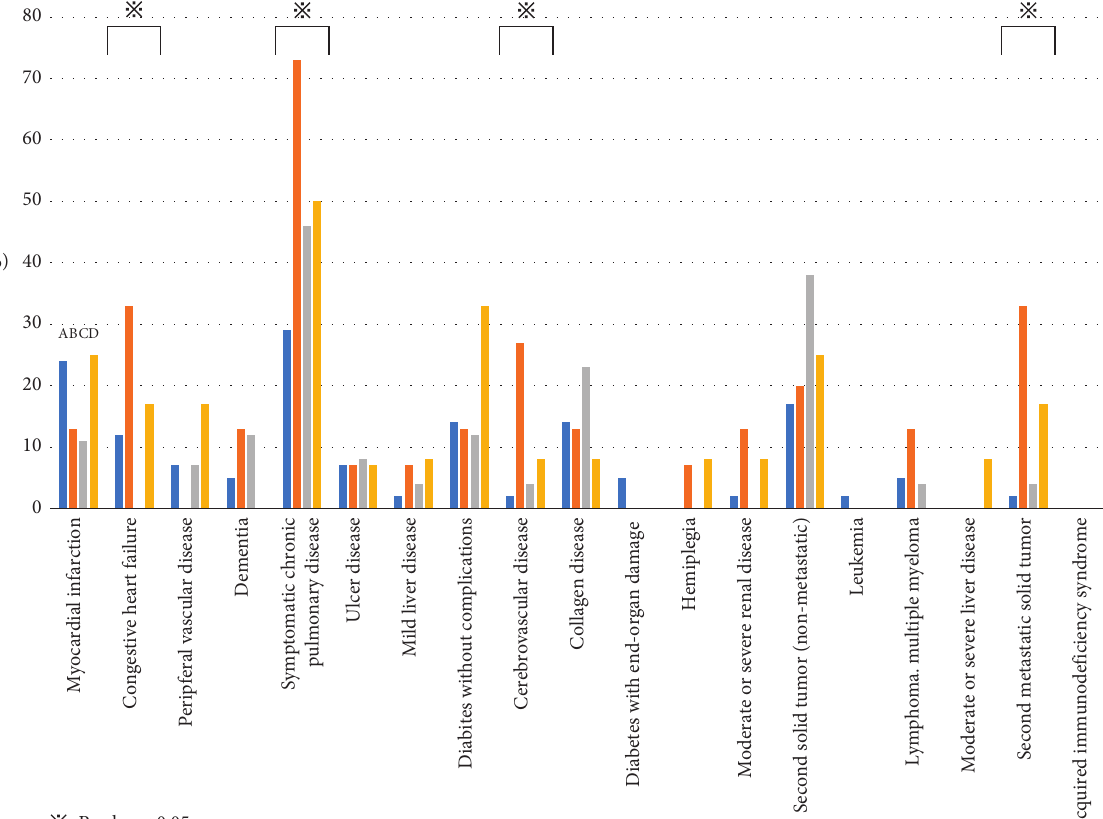
Figure 4: Incidence of complications according to serum KL-6 levels and 6-month outcomes. From the left bar, there are four groups, including survivors with low serum KL-6 (A), nonsurvivors with low serum KL-6 (B), survivors with high serum KL-6 (C), and nonsurvivors with high serum KL-6 (D) levels. The incidences of congestive heart failure, symptomatic chronic pulmonary disease, cerebrovascular disease, and second metastatic solid tumours are significantly the highest in nonsurvivors with low serum KL-6 levels (all P < 0.05). KL-6: Krebs von den